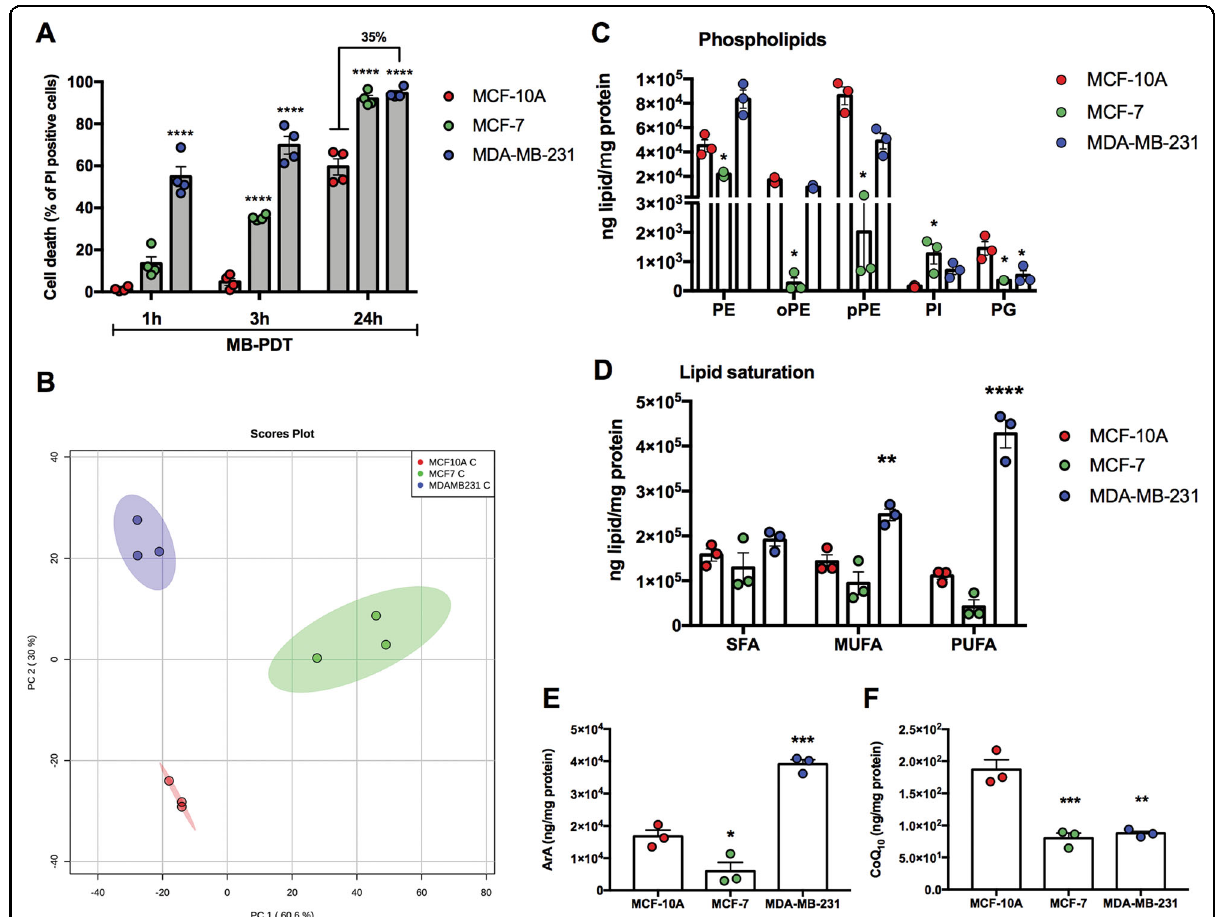
Fig. 1 Human breast cells display differential sensitivity to MB-PDT and lipid composition. A Cell death induction after 1, 3, or 24 h of MB-PDT treatment. B Score plot of the principal component analysis (PCA) of lipidomic data of BC. C Abundance of the glicerophospholipids: PE, oPE, pPE, PI and PG. D Abundance of lipids grouped by the degree of fatty acid chain saturation. Saturated fatty acid (SFA), monounsaturated fatty acid (MUFA), and polyunsaturated fatty acid (PUFA). E Abundance of ArA-containing lipids in BC. F Abundance of CoQ 10 . Dot color representation: MCF-10A in red, MCF-7 in green, MDA-MB-231 in blue. **** p < 0.0001, *** p < 0.001, ** p < 0.005, * p < 0.05 vs. MCF-10A. Results are presented as mean ± SEM. Each dot represents an independent experiment. n ≥ 3 independent